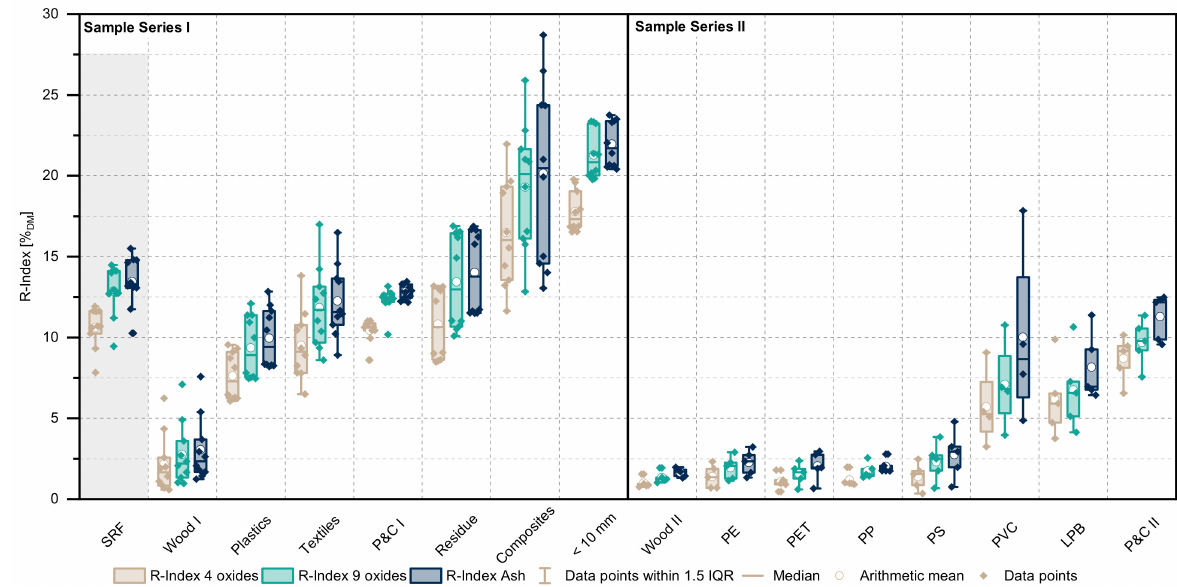
Figure 17. Calculated R-Indices for solid recovered fuel (SRF) sorting fractions (left) and specific materials extracted from SRF (right) for three scenarios considering different element oxides